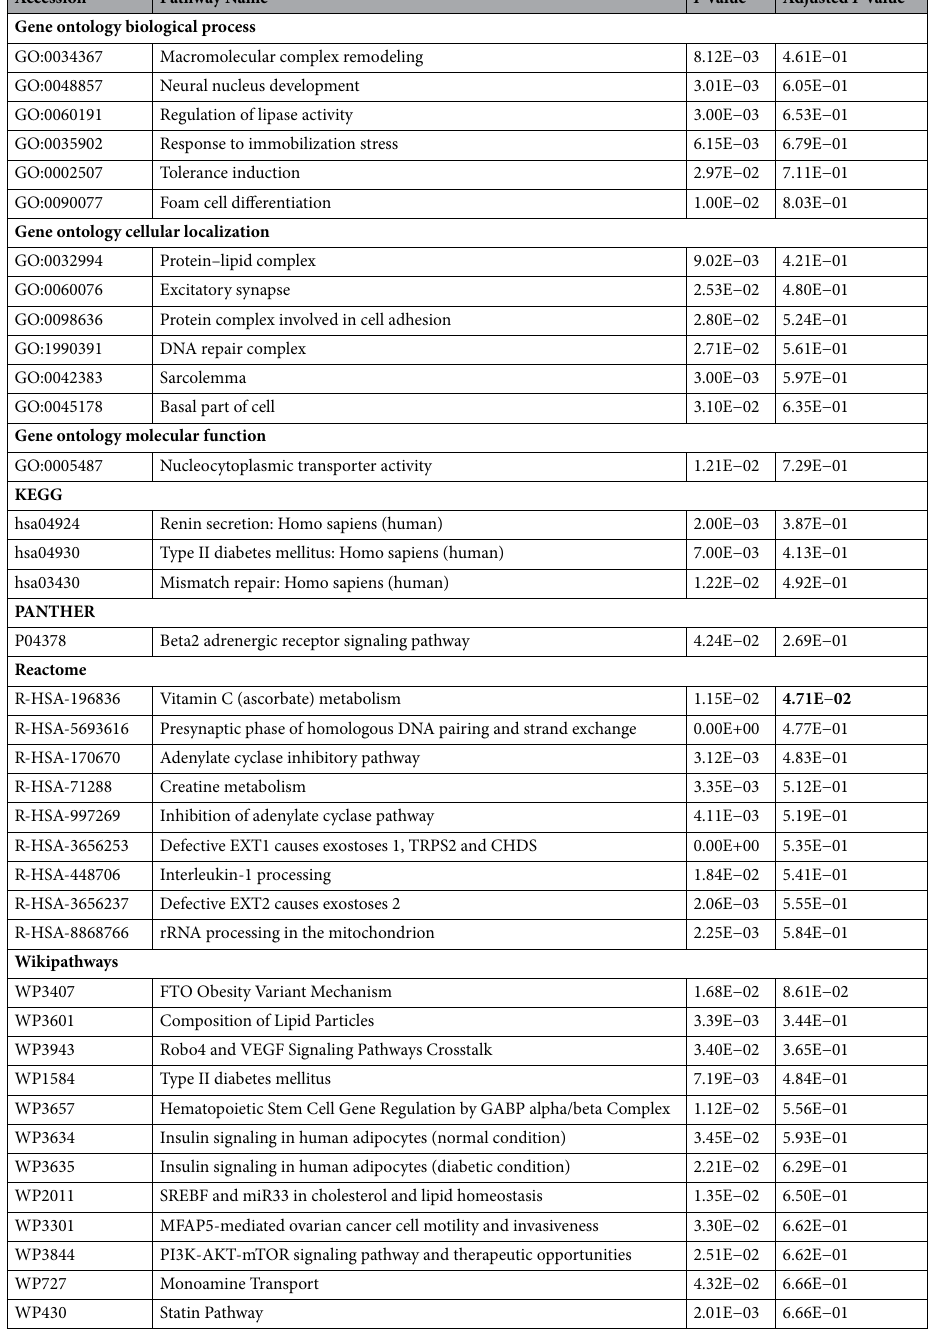
Table 5. Results of common variants analysis: a list of the most significantly enriched pathways ( P value < 0.05) from gene set enrichment analysis using WebGestalt. EXT1 Exostosin 1, TRPS2